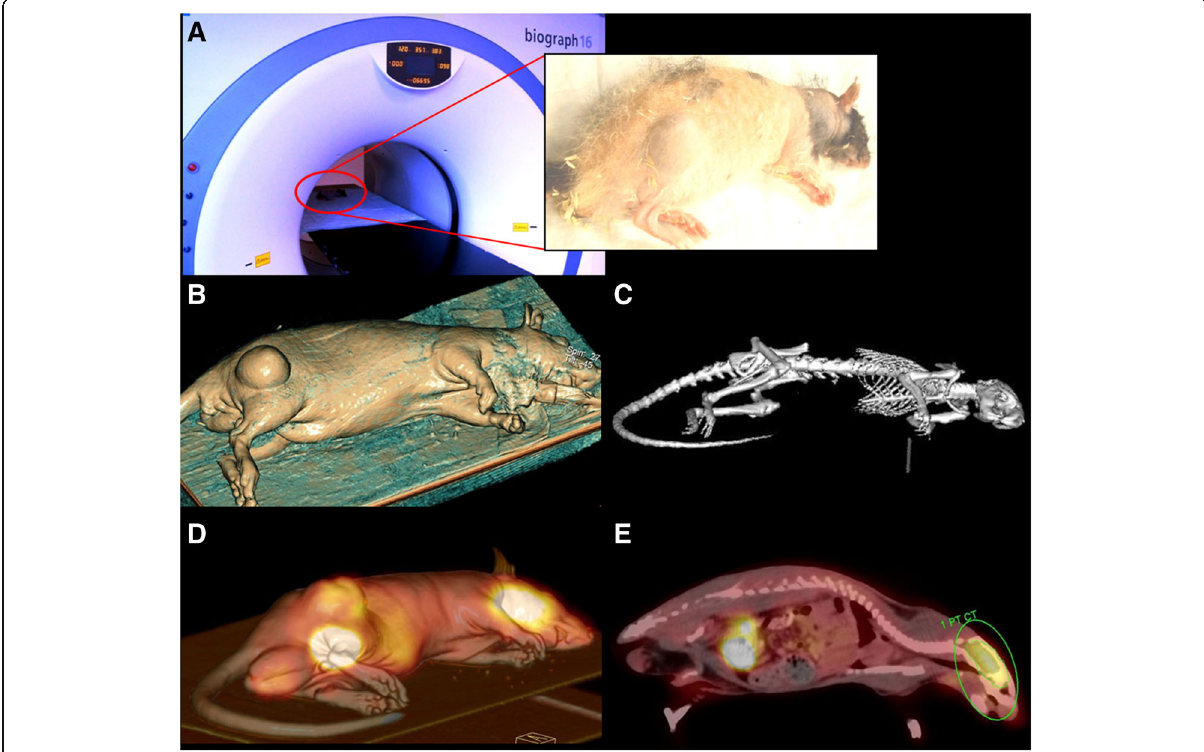
Fig. 2 a – e Clinical scanners for preclinical research — [18F]FDG-PET/CT. a Tumor-bearing nude rat while scanning in PET/CT “ biograph 16 Hi-Rez ” (Siemens Healthineers). Narcotized rat carrying the tumor at the rat ’ s right lower limb. b Reconstruction using soft tissue windowing by CT data. High image quality visualizes even surface details using clinical scanners, e.g., the tumor at the rat ’ s right lower limb. c Reconstruction using bone windowing by CT data. d 3d rigid Fusion of [18F]FDG-PET and CT data. Position as in a – c with co-registration of [18F]FDG-PET. High [18F]FDG activity in four locations, highest at brain and urinary bladder. Less intensity can be seen in the abdominal part, near to the primary [18F]FDG injection and at the tumor site at the right lower limb. e Sagittal view of [18F]FDG-PET/CT scan. Green region of interest to analyze [18F]FDG-uptake in the